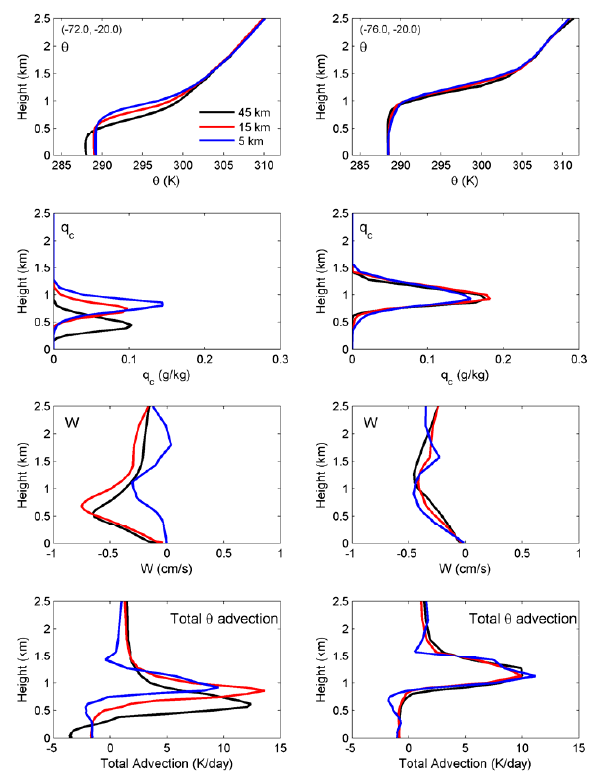
Fig. 15. Comparison of the ensembly averaged MBL structure and mesoscale forcing among the different resolution grids and locations. Left column of panels presents results from the nearshore location at 72 ° W and 20º S; the right column the offshore location at 76 ° W and 20º S; The horizontal resolution (45 km, 15 km, 5 km) is denoted in the top-left panel. The letters or words in each plot denote the variable.